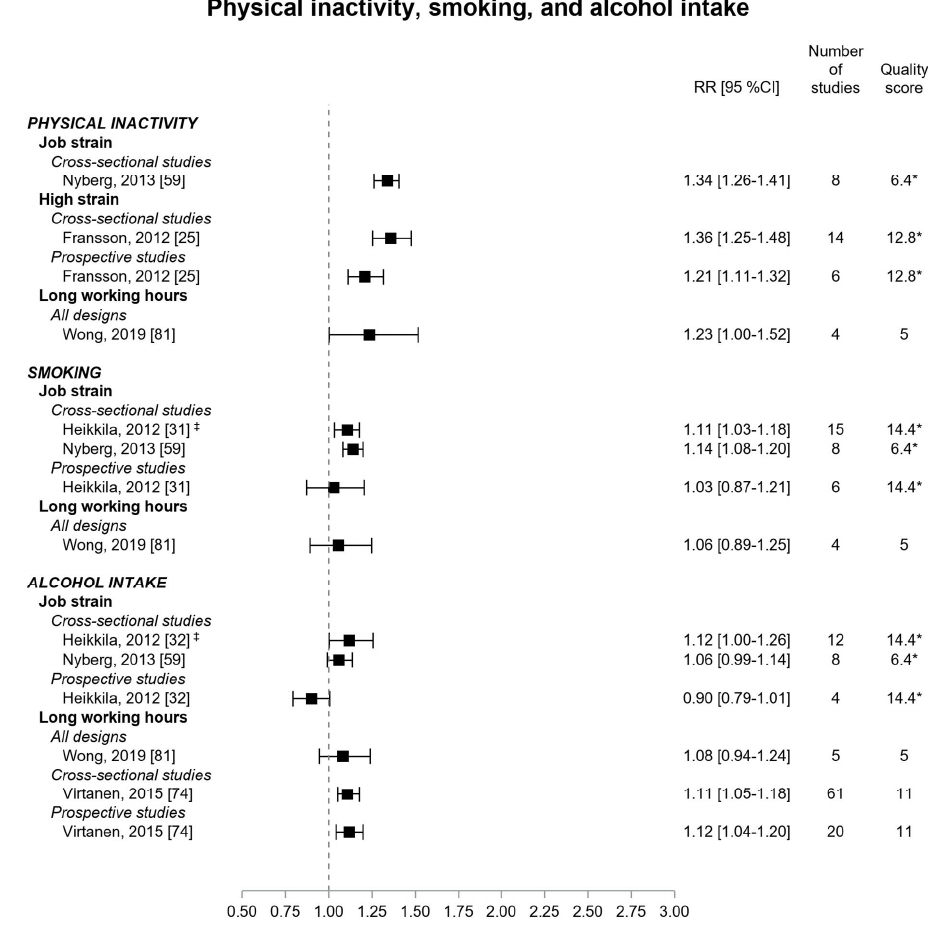
Figure 6. Pooled estimates for the associations between psychosocial work exposures and behavioral risk factors. ‡ Job strain was the outcome. * IPD-Work Consortium studies without systematic literature review.